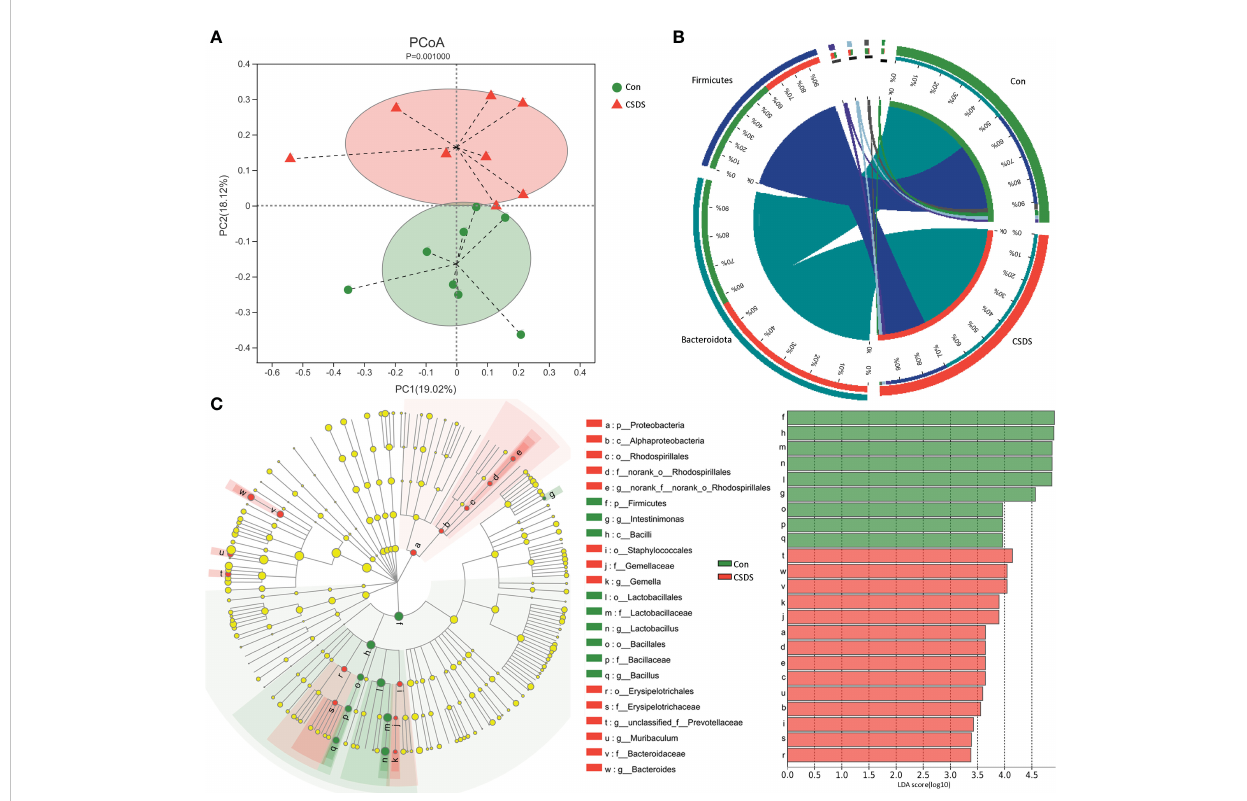
(C) the linear discriminant-analysis effect size (LEfSe) showed that there were 23 differential bacterial taxa between the two groups, and most of them (n=13) belonged to phylum Firmicutes. Con, control; CSDS, chronic social defeat stress; LDA, linear